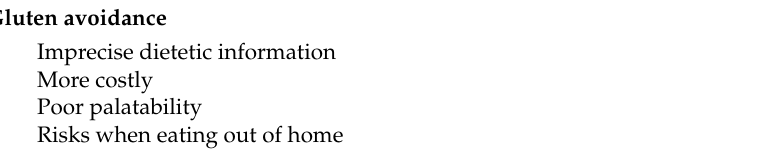
Table 1. A Summary of the challenges of the gluten-free diet from